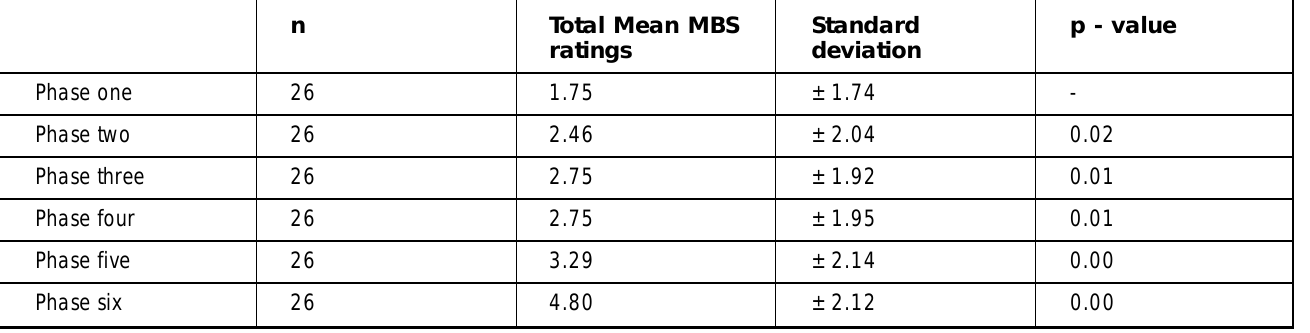
Table 2: Modified Borg scale ratings during last exercise test.